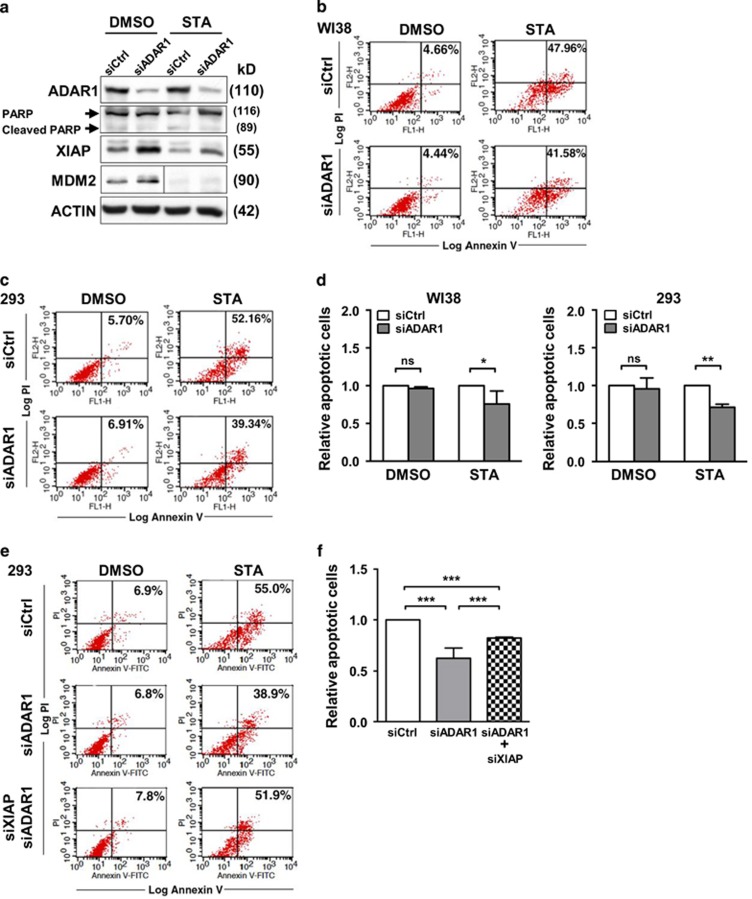
ADAR1 confers cell death protection under apoptosis signaling. (a–d) Role of ADAR1 in the cellular apoptotic response. For loss-of-function experiments, 293 or WI38 cells were transfected with siRNAs targeting ADAR1 (siADAR1) or GFP (siCtrl), and subsequently treated with 500 nM staurosporine (STA) for 4 h (a) and 12 h (b–d). Cells were harvested for either immunoblot analysis of the indicated proteins (293 cells; a) or flow cytometry-based apoptosis detection, with differential labeling of PI and Annexin V as the readout (see Materials and Methods) (WI38 in b, 293 in c). For the anti-MDM2 blots shown in (a), the control and treatment groups are of two different exposures. In (b) and (c), numbers shown in the upper right quadrant indicate the percentage of apoptotic cells. (d) Quantitative representation of extent of apoptosis for experiments shown in (b) and (c). Values were normalized to the control group and represented as means±S.D. (e) Cells harboring control (siCtrl) siRNAs or siRNAs targeting ADAR1 (siADAR1), or both ADAR1 and XIAP (siADAR1, siXIAP) were treated without or with STA and subjected to apoptosis detection by flow cytometry, which was performed as described above. (f) Quantitative representation of the results shown in (e), with columns and error bars representing means±S.D. of at least three independent experiments. Relative levels of apoptosis are shown as normalized to the Ctrl group (for statistical analyses shown in this figure: NS, not significant or P>0.05; *P<0.05; **P<0.01; ***P<0.001)